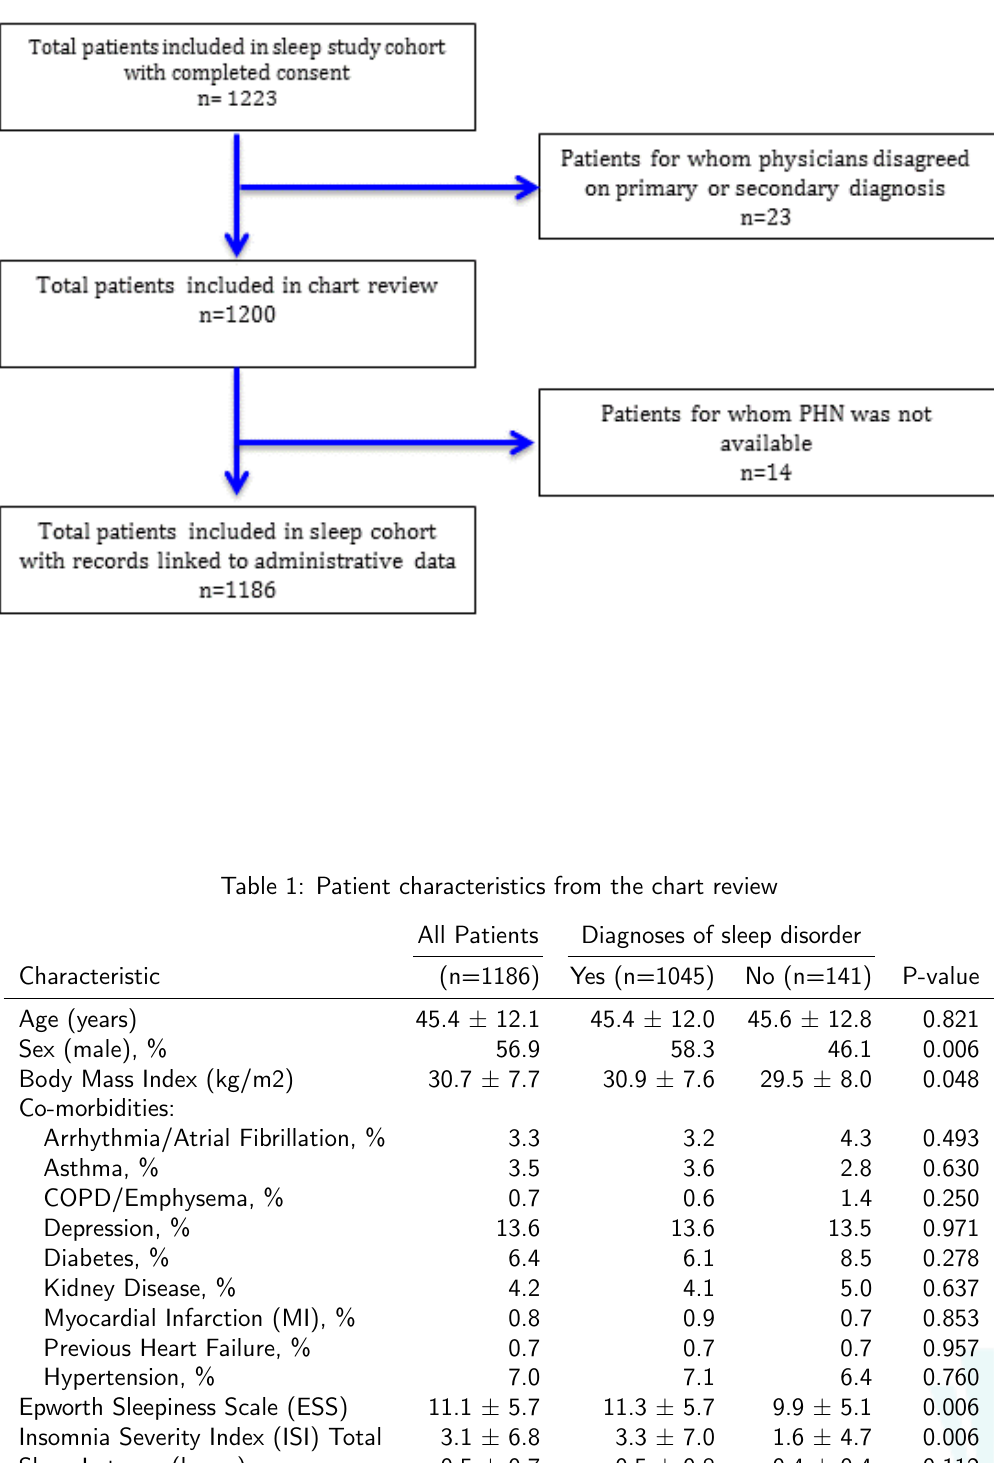
Figure 2: Study population inclusion flow diagram